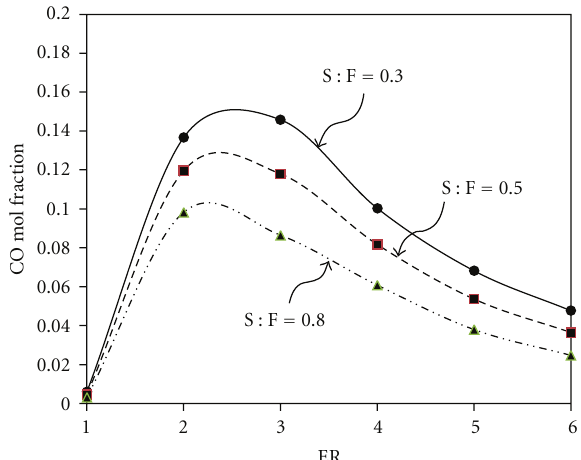
Figure 3: E ff ect of ER on CO production for various S: F, estimated with chemical equilibrium.